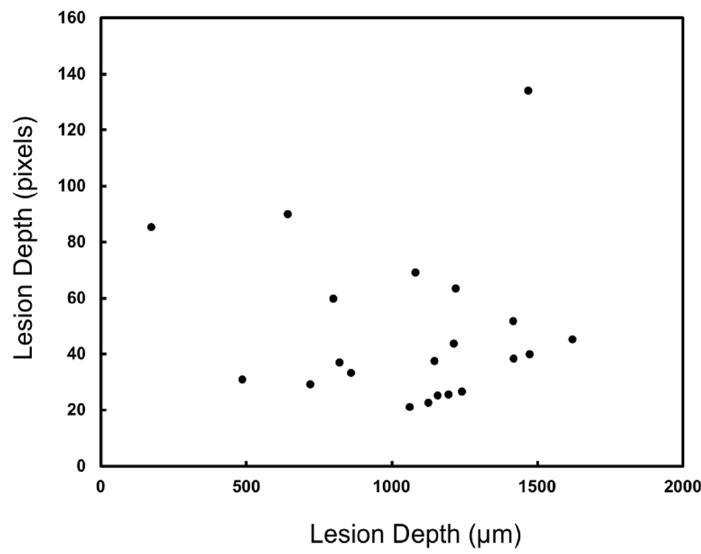
Figure 8. Lesion depth was measured in radiography (X r ) and microCT (X µ ). There was no significant correlation between the two methods ( p > 0.05). Only 22 of the 67 lesions had sufficient contrast to perform the measurements. Table 1. Mean lesion contrast ± s.d. for the SWIR methods and radiography and linear correlation coefficients (R 2 ) for the lesion depth measured with those methods compared with microCT. The number of lesions that had measurable contrast in each imaging modality out of the 67 lesions identified with microCT is also listed.